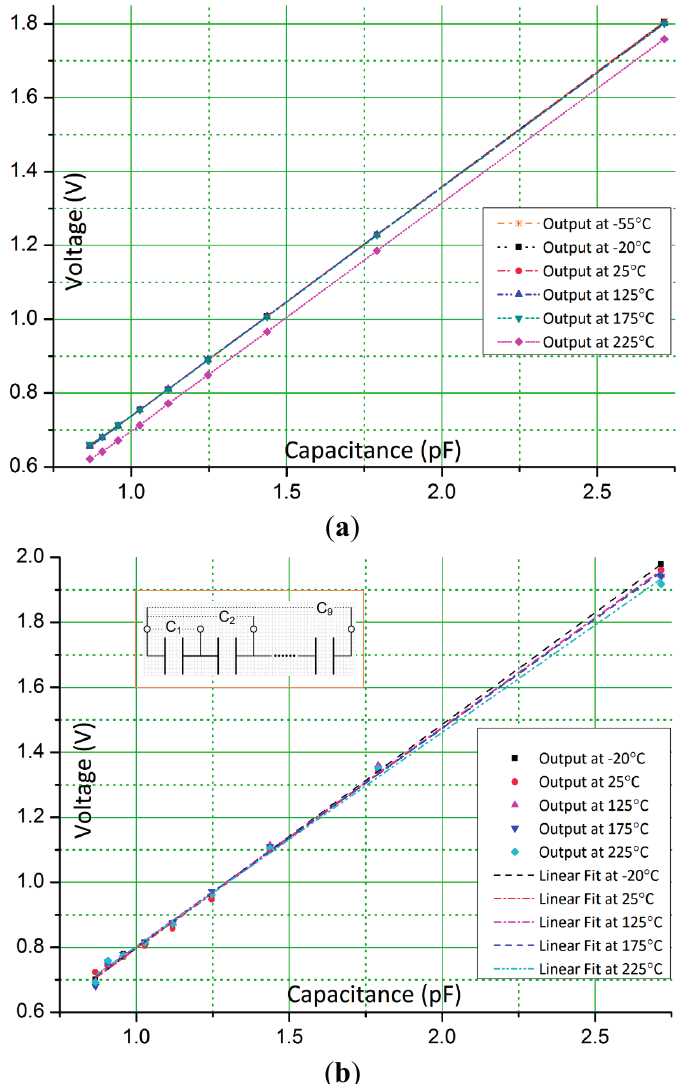
Figure 5. Output voltages of the converter circuit at different temperatures. ( a ) Simulated output voltage; ( b ) Measured output voltage. Inset: schematic of the test C sensor